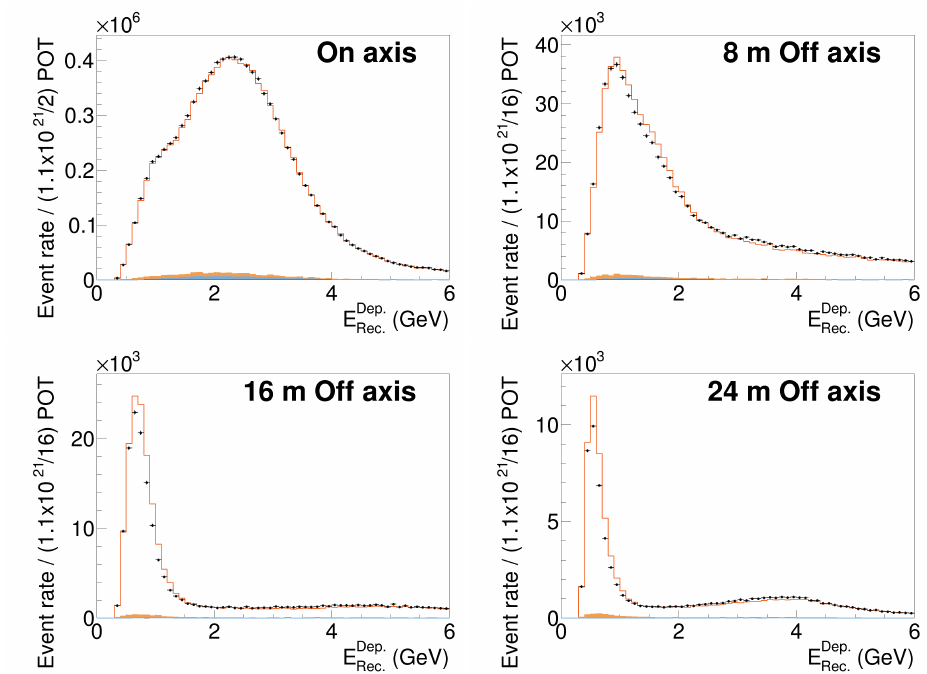
Figure 100. The predicted ND event rate per run-plan year at various off axis positions for the default GENIE simulation (orange line) and the modified ’missing proton energy’ mock dataset (black points). The model deficiencies that gave rise to the biased oscillation parameter measurements, and were not detected on-axis, can clearly be seen in the off-axis positions. The barely visible content in the histograms is the